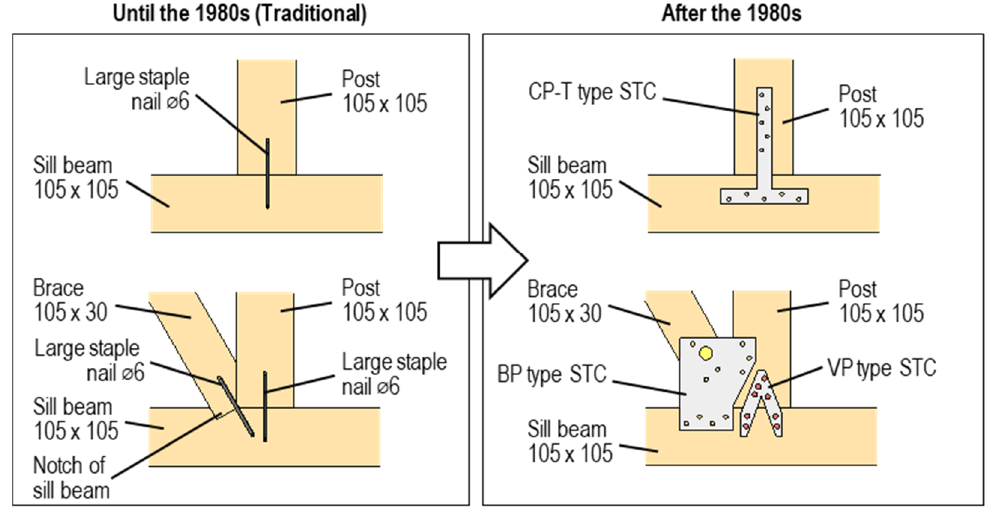
Figure 2. The typical Japanese TF connections: until and after the 1980s; dimensions in mm.